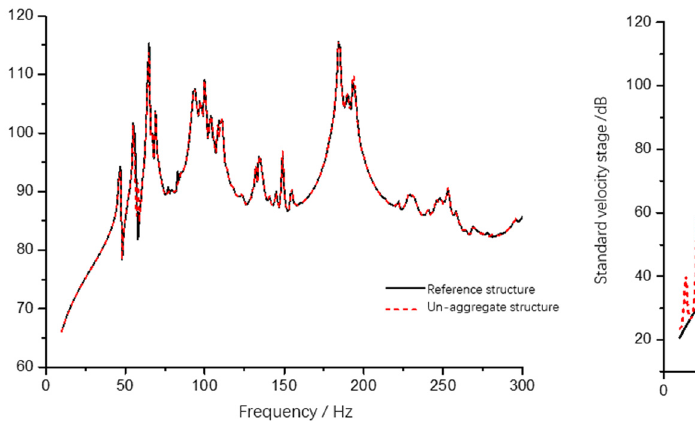
Figure 5: Mean square velocity of C cabin deck.